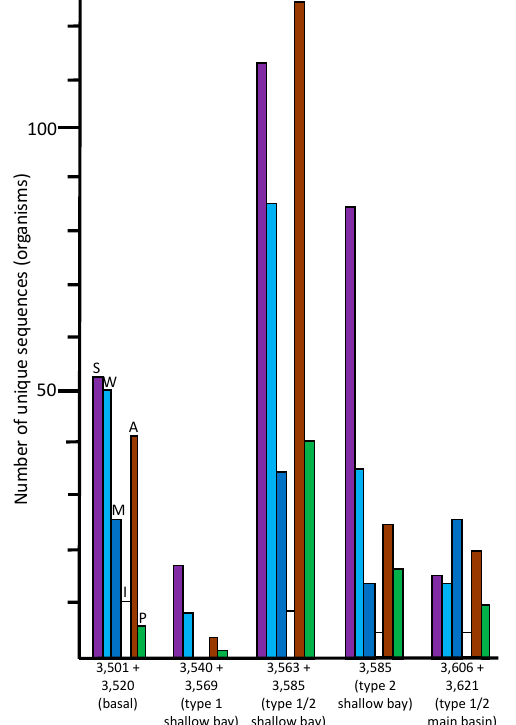
Figure 4. Numbers of unique sequences in the ice core samples that matched sequences from organisms in the NCBI database ( ≥ 97% identity, e-value < 10 − 6 ) that had been isolated from soil / sediment (S, violet), aquatic / freshwater (W, light blue), marine / saltwater (M, dark blue), permafrost / ice (I, white), animal (A, brown), or plant (P, green)